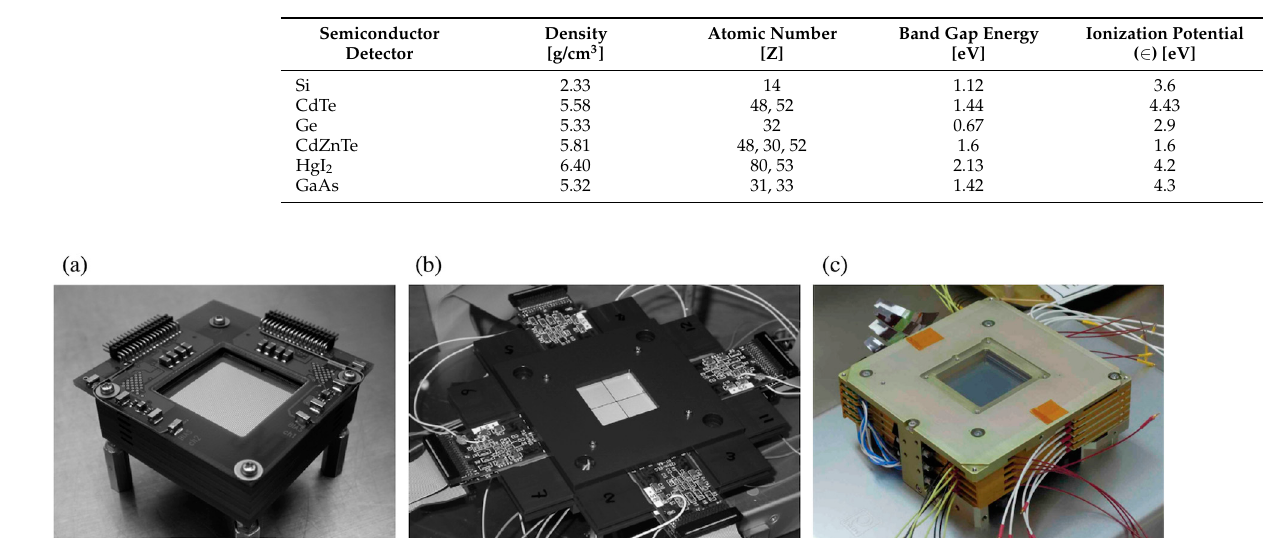
Table 2. Properties of some semiconductor detectors widely used in Compton cameras.